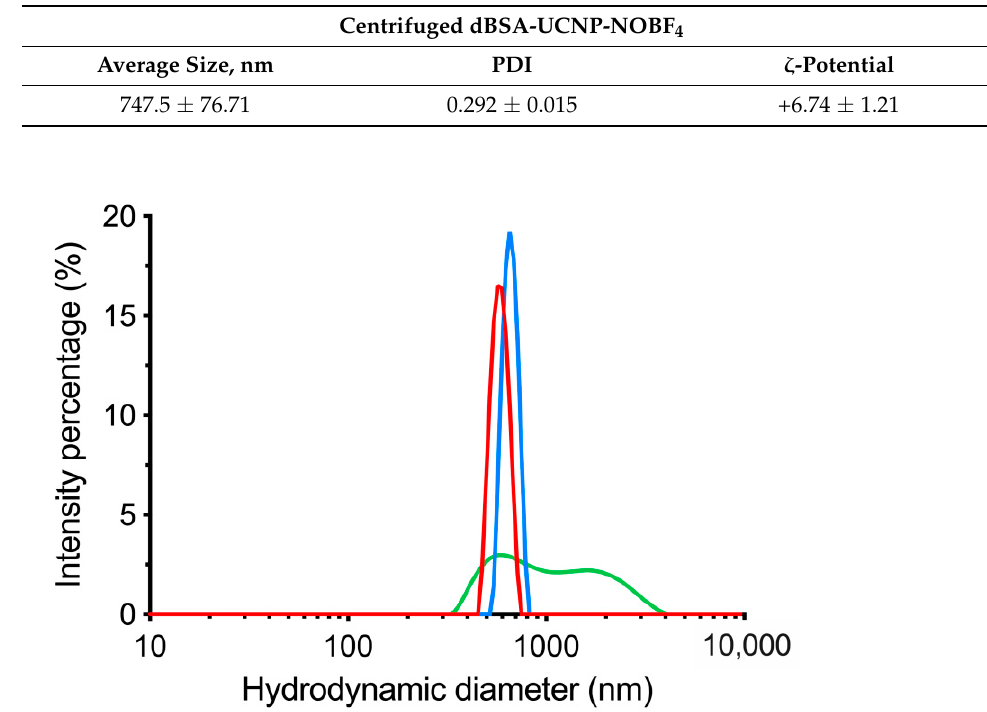
Table 3. The hydrodynamic diameter and ζ -potential of dBSA-UCNP-NOBF 4 after centrifugation acquired by DLS and ELS, respectively.